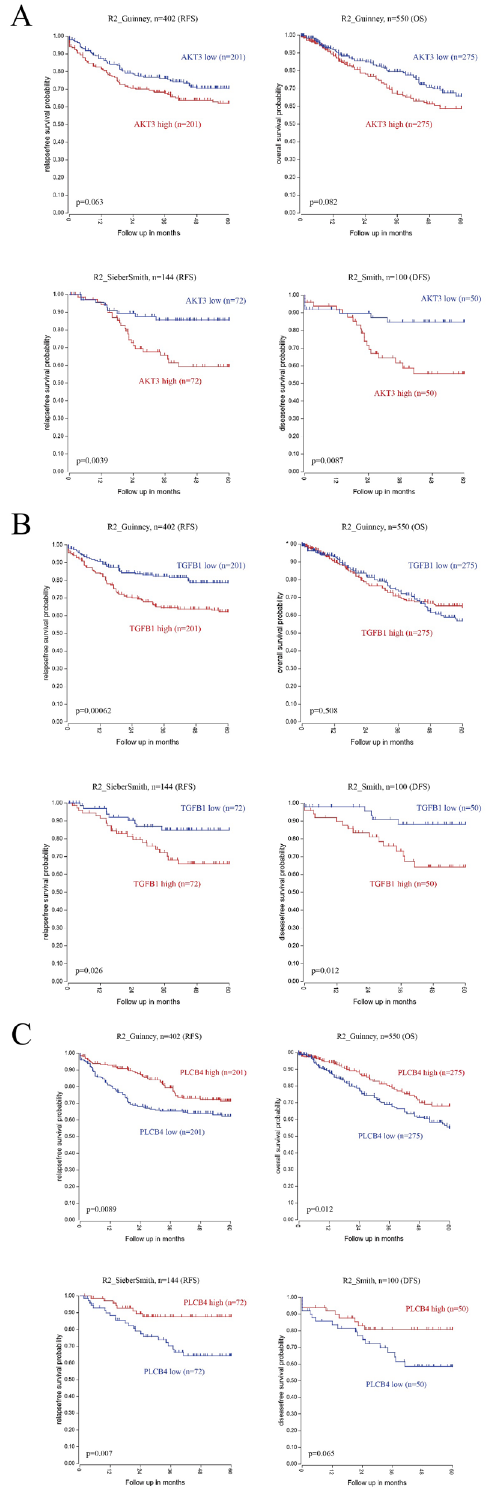
Figure 6. Kaplan Meier survival curves presenting the significant prognostic relationship between high and low expression of key genes by using the R2 platform. Up-regulated genes: ( A ) AKT3 ( B ) TGFB1 ; down-regulated genes: ( C ) PLCB4